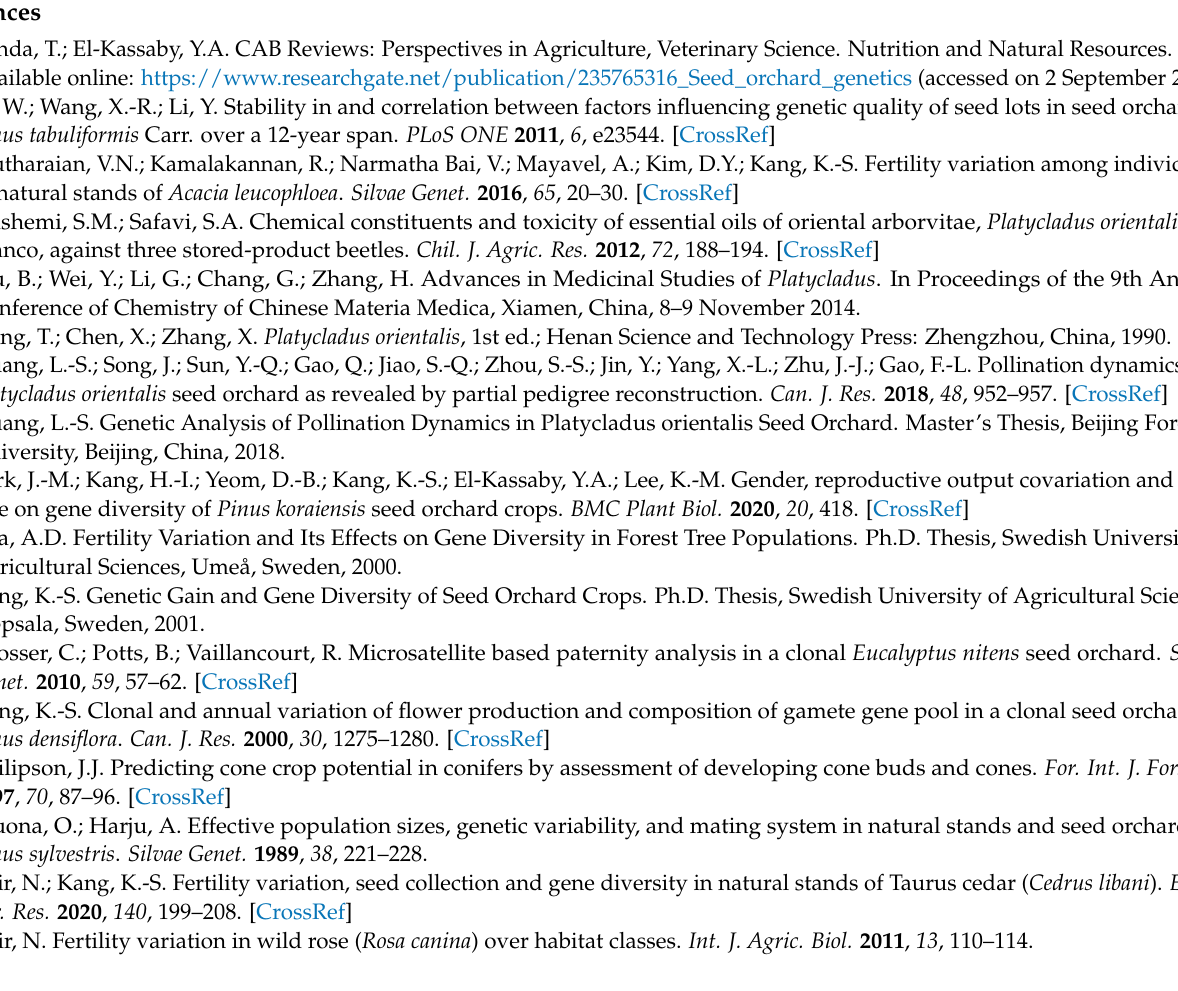
Table S2. Coefficient of variation ( CV f ) and sibling coefficient ( Ψ f ) for female cones production in the P. orientalis clonal seed orchard ( N = 5398). Table S3. Coefficient of variation ( CVm ) and Table S4. Maleness index of 166 clones in 2017. Figure S1. Coefficient of variation ( CV ) of female and male strobili productions for different years in the P. orientalis clonal seed orchard. Different colors of labels correspond to different provenances. Figure S2. The mean value of female and male strobili productions for different years in the P. orientalis clonal seed orchard. Figure S3. The median value of female and male strobili productions for different years in the P. orientalis clonal seed